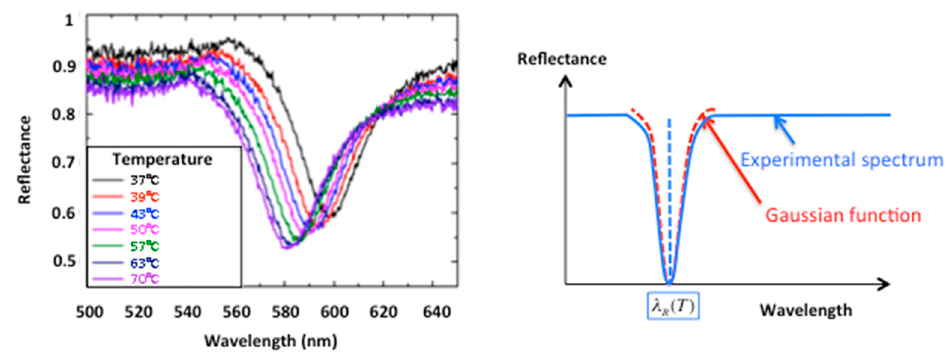
Figure 9. Experimental wavelength spectra for different temperatures and the principle of the resonance position determination.